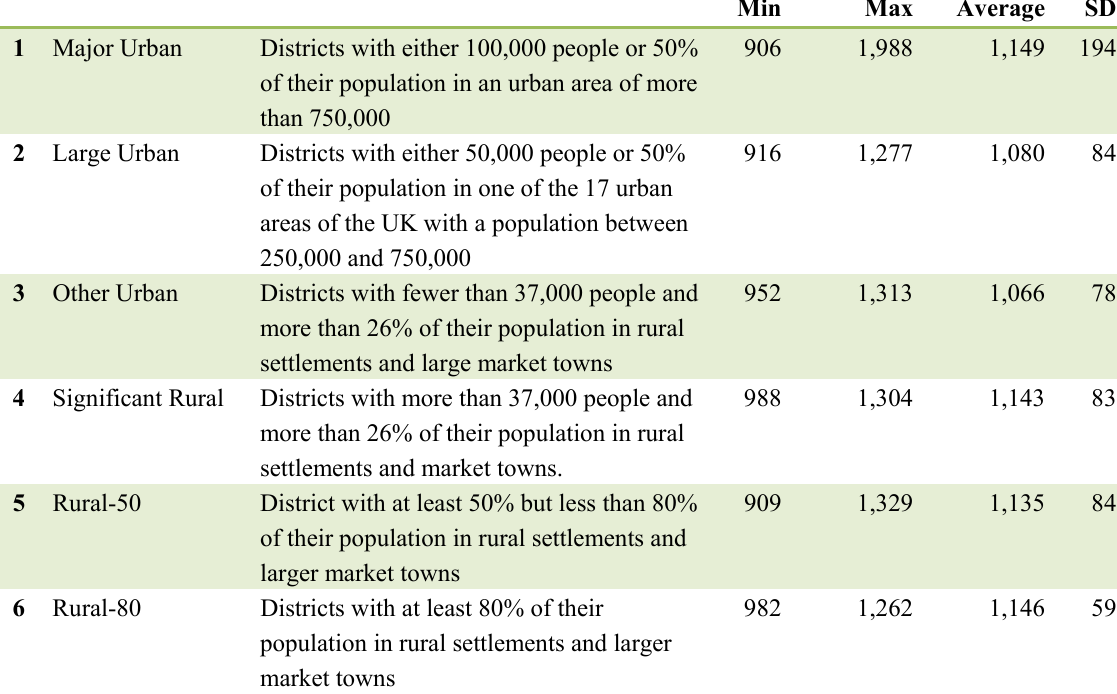
Table 1. Consumption water footprint by degree of urbanization (m 3